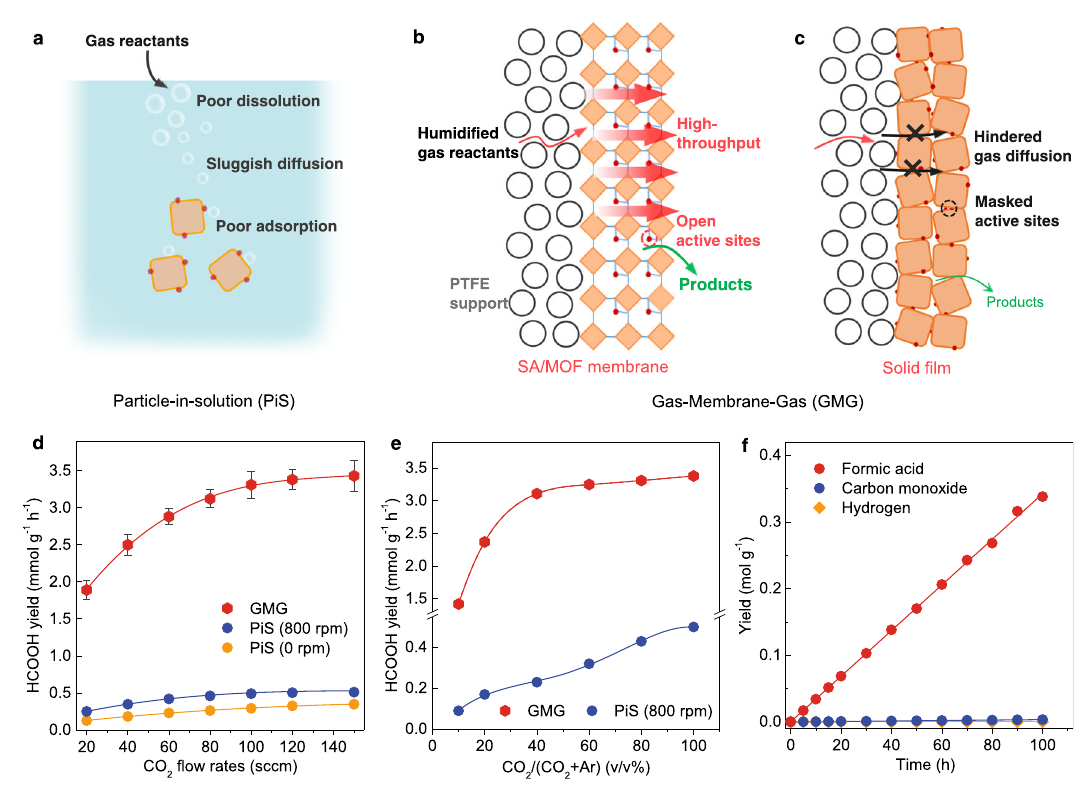
Fig. 3 Photocatalytic CO 2 RR on SA/MOF membranes. a In the particle-in-solution (PiS) mode, gas-phase CO 2 was fed into the aqueous photocatalyst dispersion and then reduced on the water fl ooded surfaces of catalysts. b In the gas-membrane-gas (GMG) mode, humidi fi ed CO 2 gas was fed through the SA/MOF membrane, where water vapor was carried by the CO 2 stream. c Schematic illustration for the solid fi lms fabricated by non-porous semiconductor particles. d HCOOH yields on Ir 1 /A-aUiO particles (PiS) and membrane (GMG) under different CO 2 fl ow rates, respectively. e HCOOH yields on Ir 1 /A-aUiO particles (PiS) and membrane (GMG) under different CO 2 concentration (in Ar mixtures), respectively. f Time course of HCOOH, CO and H 2 evolution on Ir 1 /A-aUiO membrane (GMG). All the photocatalytic reactions were performed under visible light (>420 nm). The CO 2 fl ow rates in e and f were fi xed at 120 sccm. Error bars represent the standard deviation for three independent catalysis